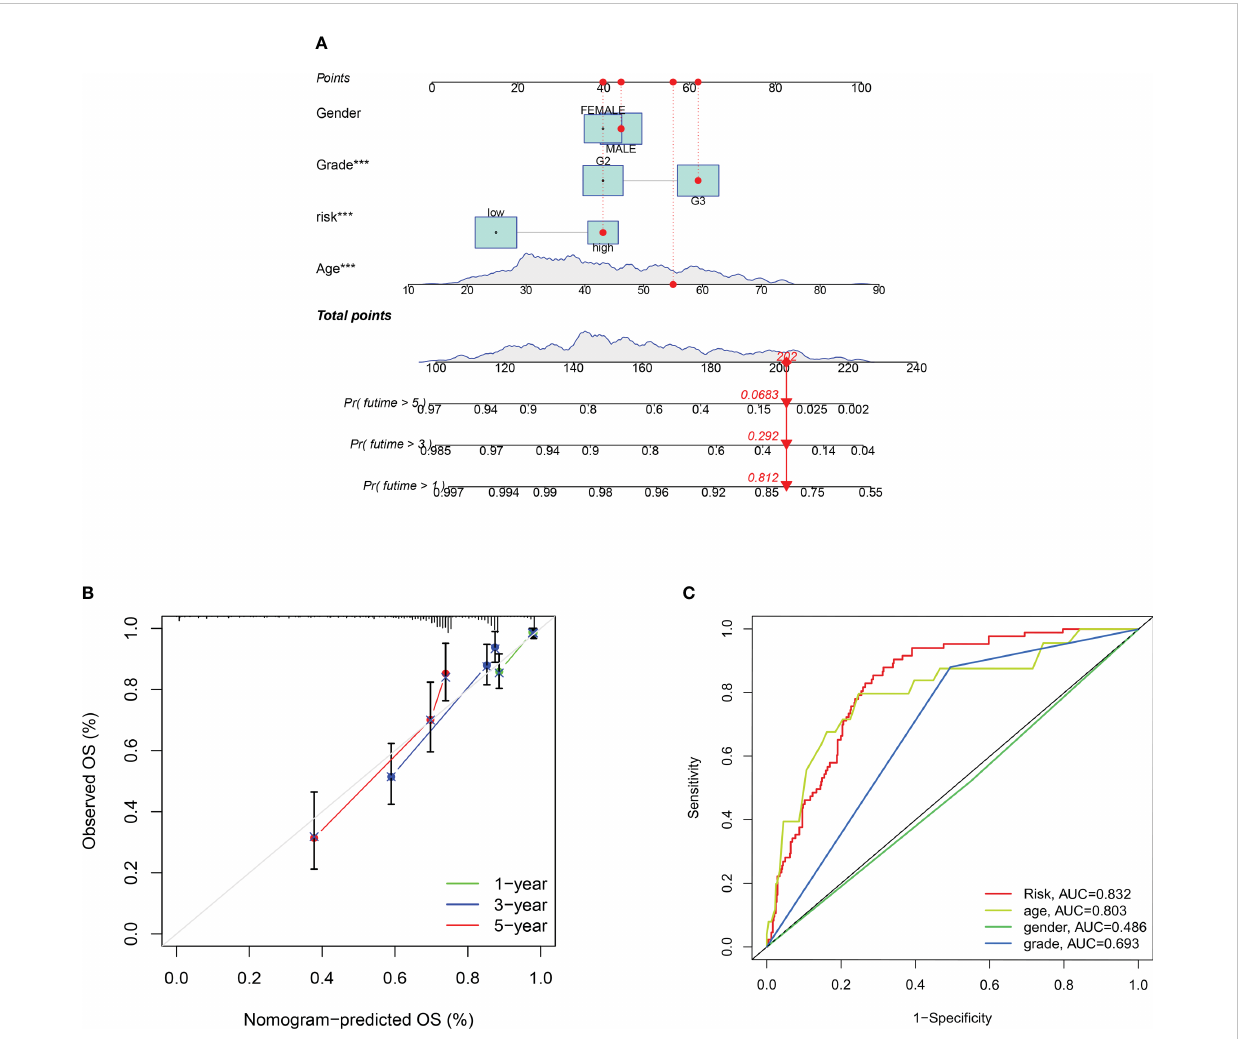
FIGURE 7 Construction of a nomogram to predict the individualized probability of survival in glioma patients. (A) Columnar line plot; (B) Columnar line plot calibration curve; (C) ROC curve for predicting clinical traits and risk scores in the training set. P values (***P <